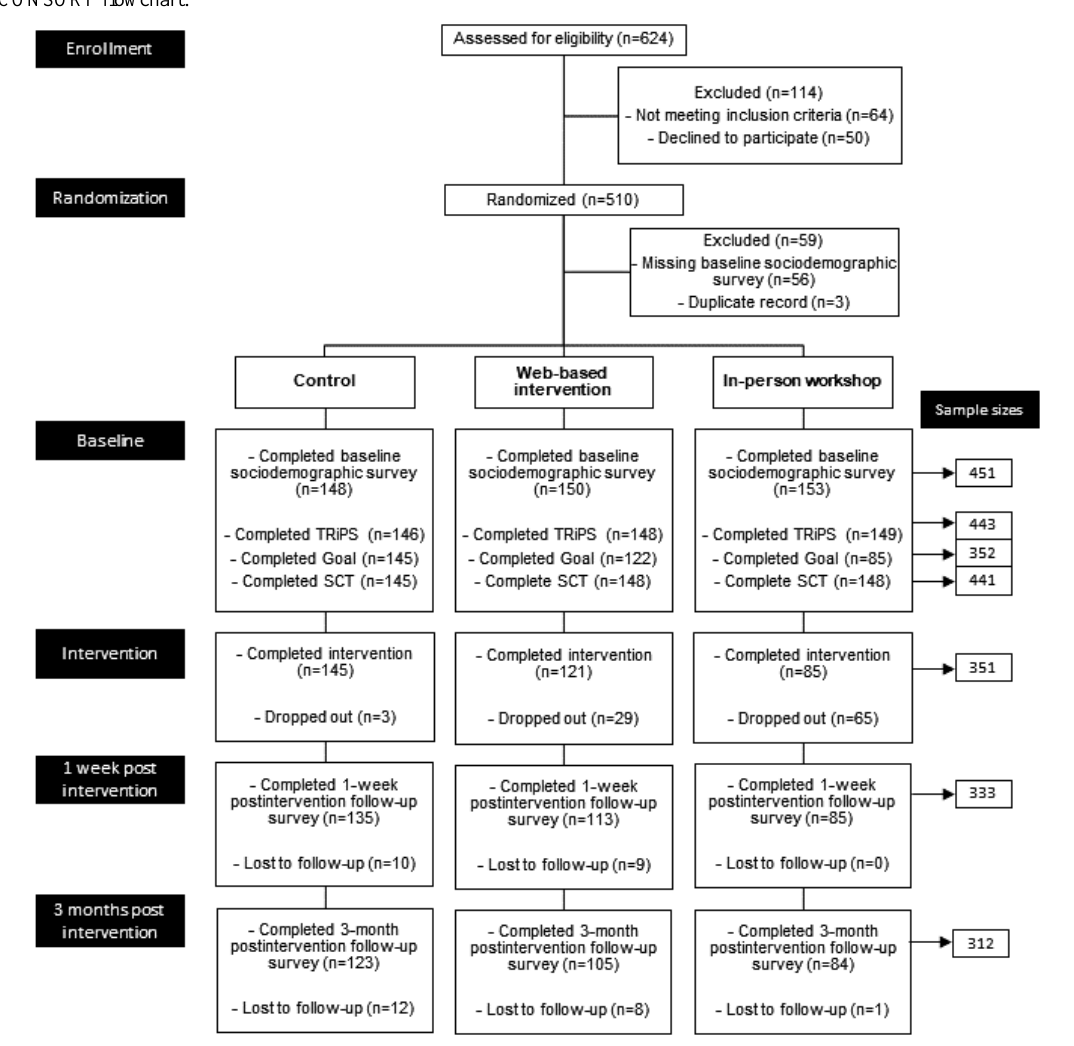
Figure 2. CONSORT